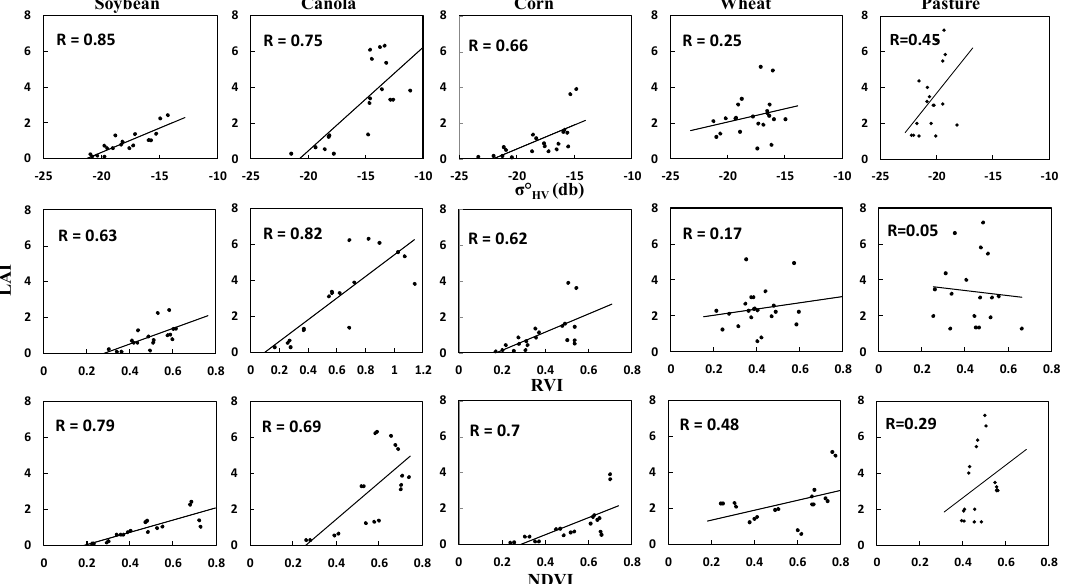
Figure 4. The plots of LAI against three vegetation descriptors: σ ° HV (top row), RVI (middle row) and NDVI (bottom row) for each crop type.